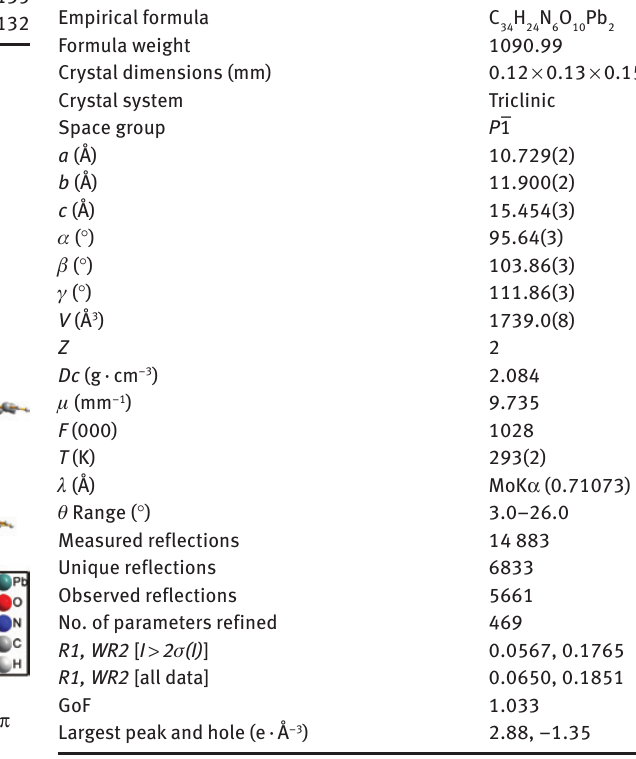
Table 3: Crystal data and refinement